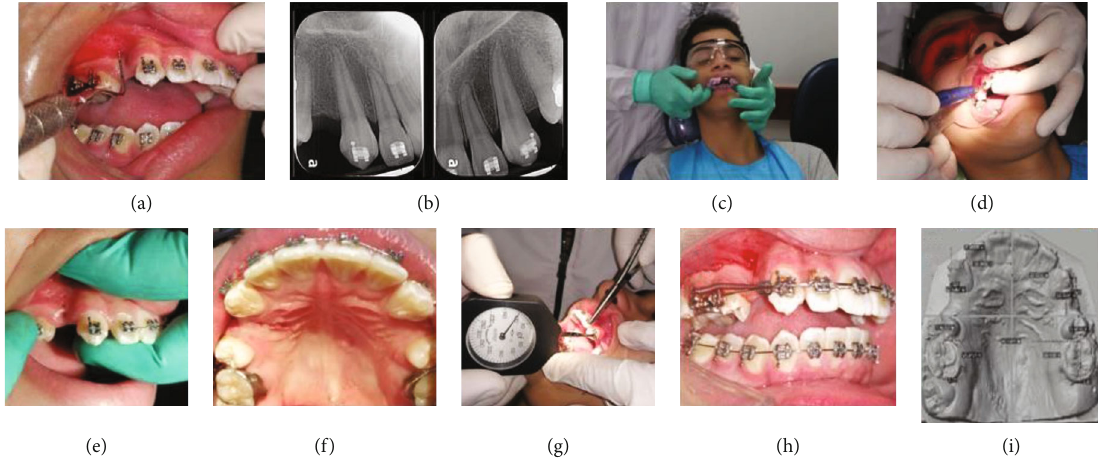
Figure 1: (a) Periodontal exam. (b) Digital periapical radiographs of the canines. (c) Impression taking. (d) Performance of MOPs with Propel®. (e) Buccal MOPs. (f) Palatine MOPs. (g) Measurement of 100g of force with an ATG-500-1 ALIYIQI® dynamometer. (h) Intervention completed. (i) Digitized upper model.